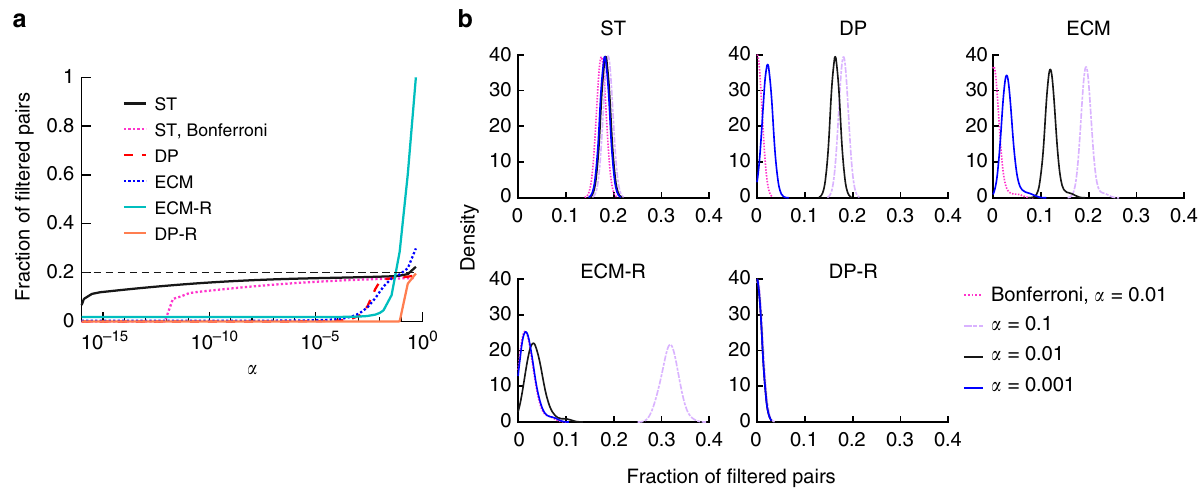
Fig. 2 Fraction of signi fi cant pairs detected in synthetic temporal networks. Synthetic networks are generated such that exactly 20% of edges have strong ties. We generate 100 networks with N = 300, T = 300, and we use Δ = 10 (see Supplementary Note 3 for a detailed description of synthetic networks). a Average fraction of signi fi cant ties as a function of the signi fi cance level. The dotted pink line denotes ST edges with Bonferroni correction for multiple tests. b Distribution of the fraction of signi fi cant pairs for different signi fi cance levels